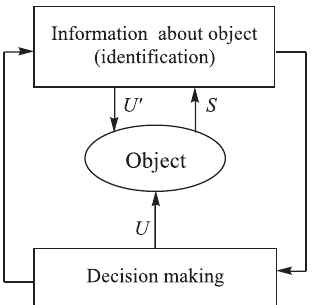
Fig. 2. The control